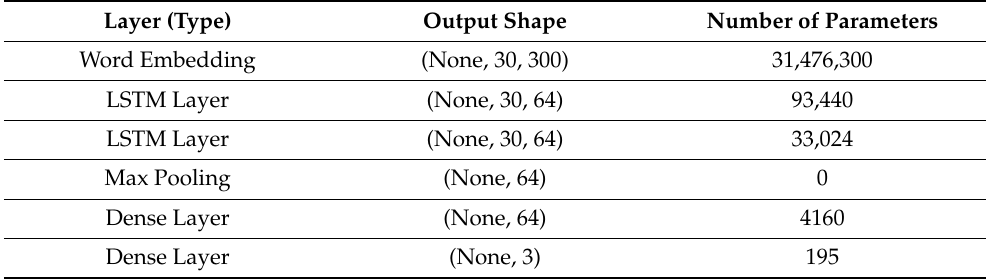
Table 5. Double-layer LSTM architecture.